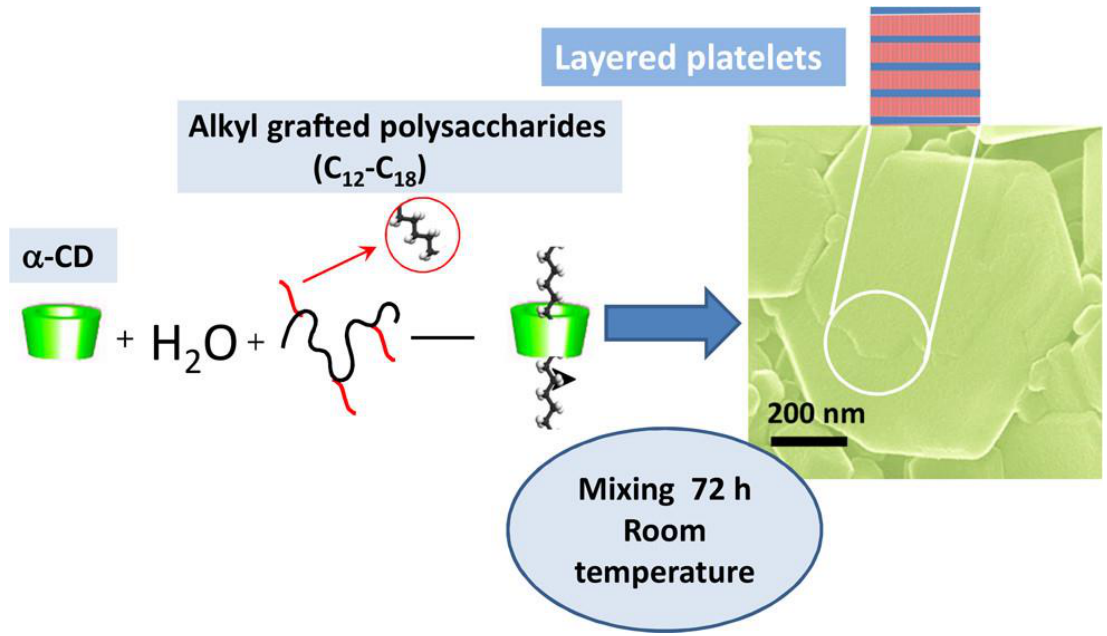
Figure 16. Schematic view of the complex formation between α-CD and alkylated polysaccharides followed by platelet organization in water. Reprinted with permission from [268]. Copyright 2018 American Chemical Society.